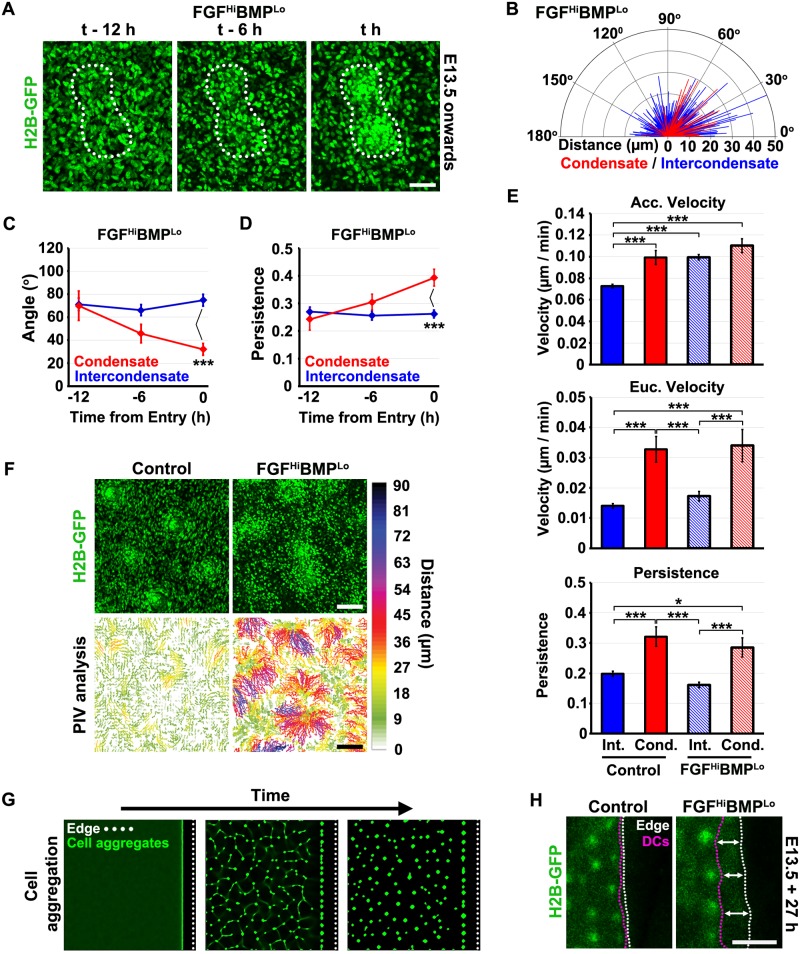
Cell behaviours underlying mesenchymal self-organisation.(A) Time-lapse images showing dermal condensate formation in FGFHiBMPLo conditions. Scale bar: 50 μm. (B) Protractor plot showing the distribution of Euclidean angles and Euclidean distances of individual cell movements in 6-h windows for cell tracks that start outside of, but ultimately terminate in, a follicle (condensate = red) and those that remain outside (intercondensate = blue) under FGFHiBMPLo conditions. Tracking was halted on cell entry. Plots showing (C) the mean Euclidean angle and (D) the mean level of persistence of condensate and intercondensate cells for 360-minute windows relative to time of entry into the condensate. From 6 h before entry, the condensate-bound cells show oriented and persistent movement under FGFHiBMPLo conditions. Error bars represent SEM (condensate cells n = 17, 21, and 25 and intercondensate n = 91, 104, and 108 for 12, 6, and 0 h before entry, respectively). Statistical significance was calculated using a Kruskal–Wallis test followed by Mann–Whitney U tests with Bonferroni’s correction (***p < 0.001). (E) Comparison between per track summaries of condensate (Cond.) and intercondensate (Int.) cells under control or FGFHiBMPLo conditions for (top) accumulated velocity, (middle) Euclidian velocity, and (bottom) persistence. Statistical significance was calculated using a Kruskal–Wallis test followed by Mann–Whitney U tests with Bonferroni’s correction (*p < 0.05, ***p < 0.001). Error bars represent SEM (control intercondensate n = 292, control condensate n = 28, FGFHiBMPLo intercondensate n = 137 and FGFHiBMPLo condensate n = 33). Raw tracking data for (B–E) can be found in S2 Data. (F) Particle image velocimetry analysis of normal and FGFHiBMPLo condensate formation over 30 h. Coloured tracks show very local cell movement in control conditions but a much broader field of recruitment for the mesenchyme-only patterned condensates. Colour scale shows track length. Scale bar: 100 μm. (G) Simulation of boundary effects on patterning in chemotactic aggregation-driven patterning. (H) Experimental test of pattern behaviours. Distinct pattern behaviours at tissue edges. Under control conditions, primordia align along the edge. FGFHiBMPLo condensates align with but form at a distance from boundaries introduced in skin explants prior to pattern formation. White dotted lines indicate the boundary. Magenta dotted lines indicate the extent of the patterned region where dermal condensates form. Scale bar: 250 μm.